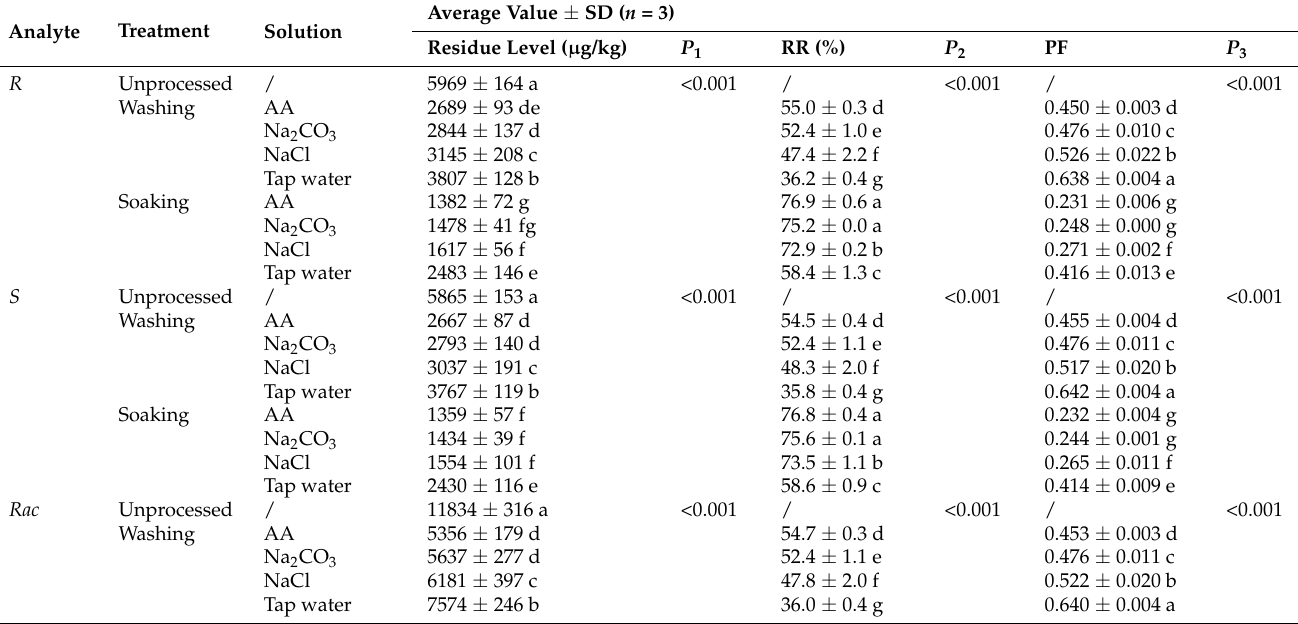
Table 3. Residue level, RR, and PF values of mandipropamid in unprocessed, washing, and soaking Chinese cabbage